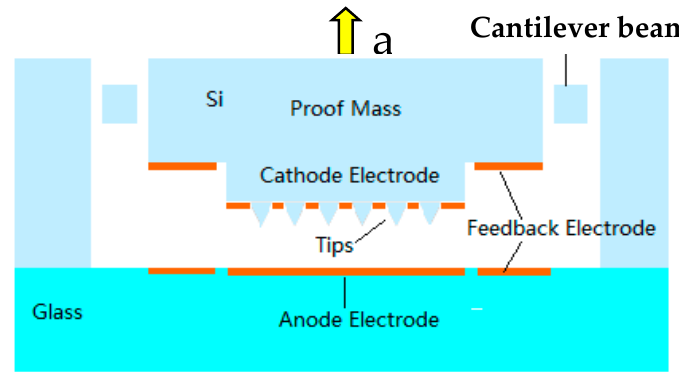
Figure 2. Emission current density vs. the curvature radius of the tip.